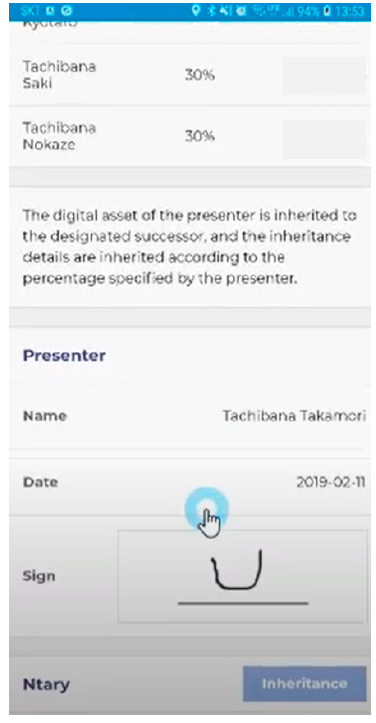
Figure 17. Legacy inheritances smart contract sign storage screen.